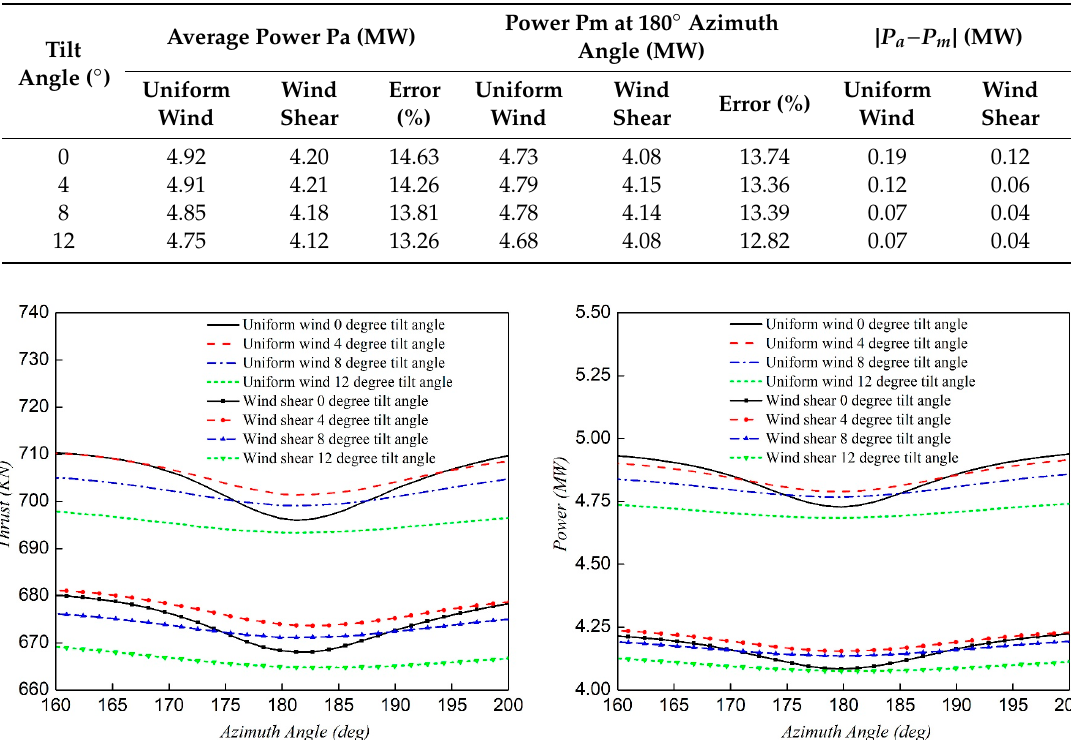
Table 8. Power for uniform wind and wind shear flow conditions at V hub = 11.4 m / s ( γ = 0.2, I ref = 0.14).